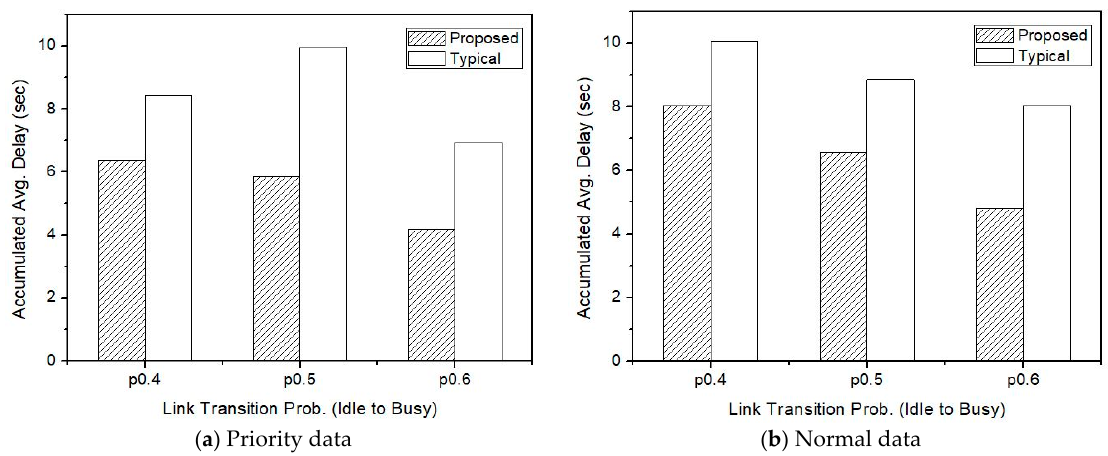
Figure 11. Transmission delay when IoV high ‐ priority is 30%.